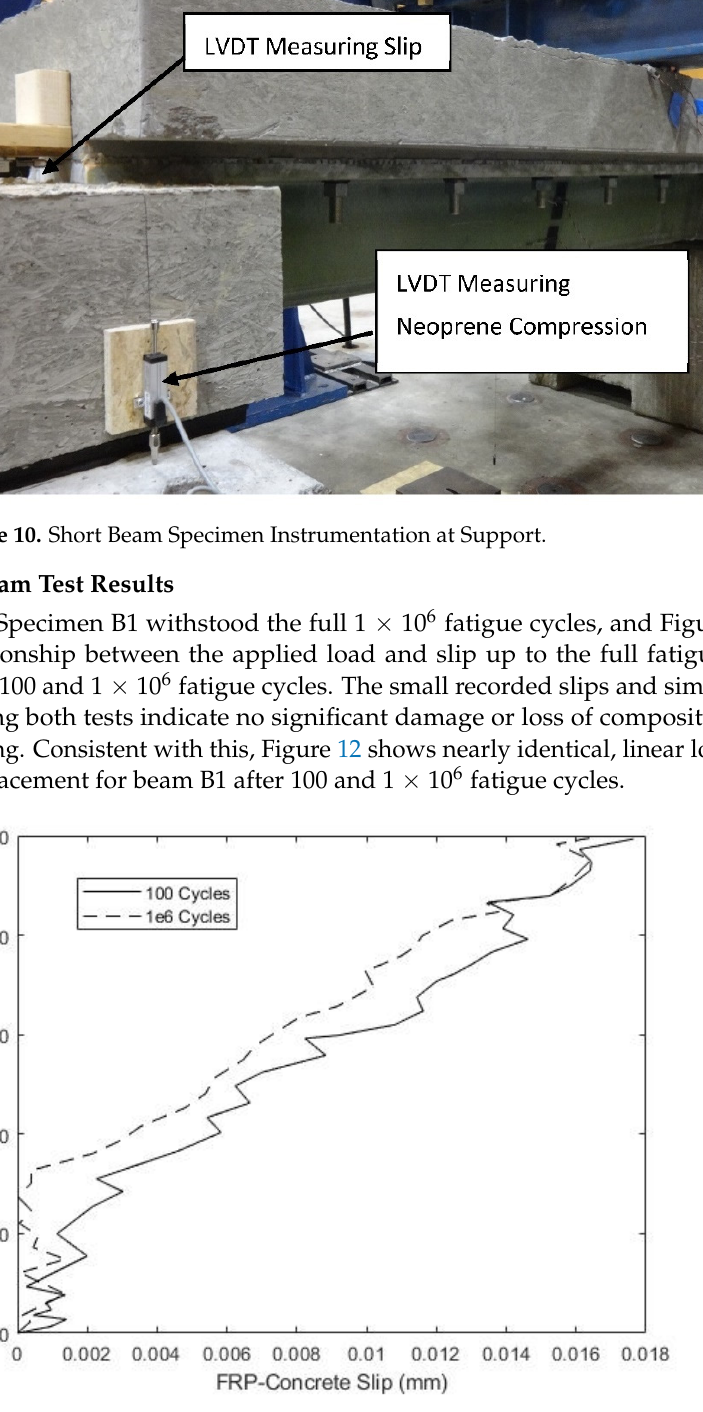
Figure 12. Beam B1 Service Load vs Mid-span Displacement during Load Cycling. The load versus mid-span displacement results, gathered during the strength testing of beams B1 and B2, are given in Figures 13 and 14, respectively. Beam B1 was initially loaded with the actuator positioned at mid-span, as represented by the solid curve in Fig- ure 13, but the maximum actuator capacity was reached before catastrophic failure, and the beam was then unloaded. In order to increase internal shear between the load point and one support to induce failure, the actuator was subsequently shifted 30.5 cm closer to one support. This increased the maximum shear in the beam by 25%, from (cid:1842)/2 to 0.625(cid:1842) , for a given actuator load (cid:1842) . The results of the offset load test are given in Figure 13 by the dotted curve, and shifting the actuator was successful at producing failure. For con- sistency, the same protocol of initially loading at mid-span, followed by offsetting the ac- tuator 30.5 cm closer to one support, was also used to test beam B2, and its load-displace- ment response is shown in Figure 14. Figure 15 includes a photo of B1 after failure high- lighting the diagonal cracking of the deck that coincided with the failure of the concrete ridges.